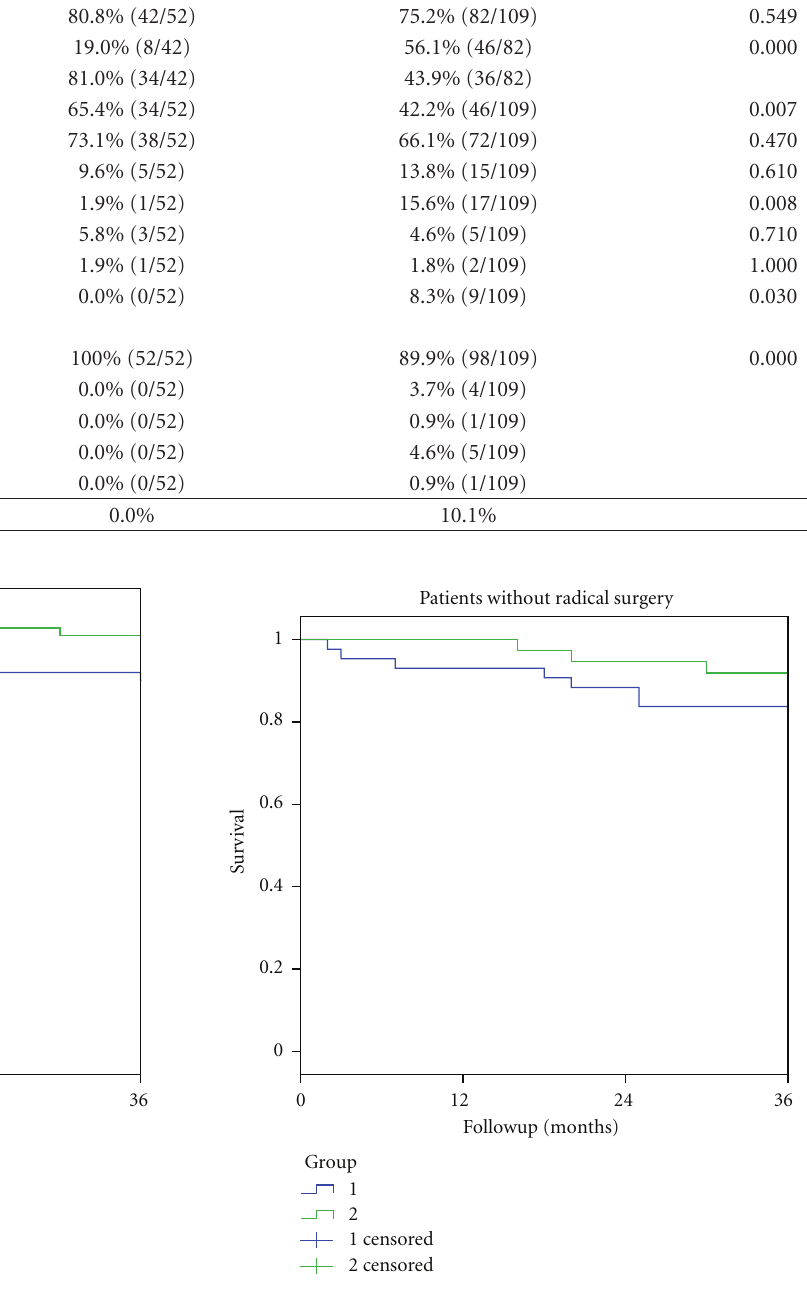
Figure 2: 3-year survival rates for patients seen in the two time periods from January 1994 to June 2003 (Group 1) and from July 2003 to December 2011 (Group 2).